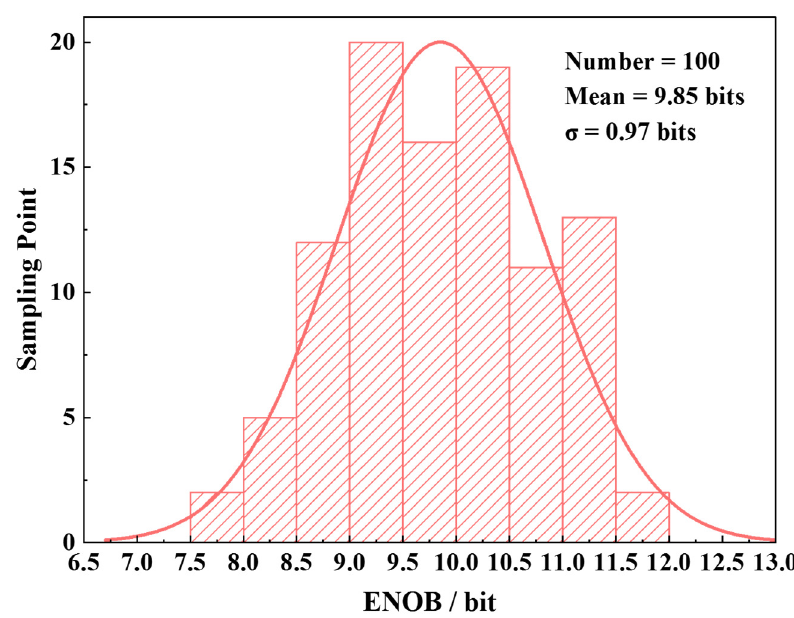
Figure 9. The PVT simulation of the SAR ADC.